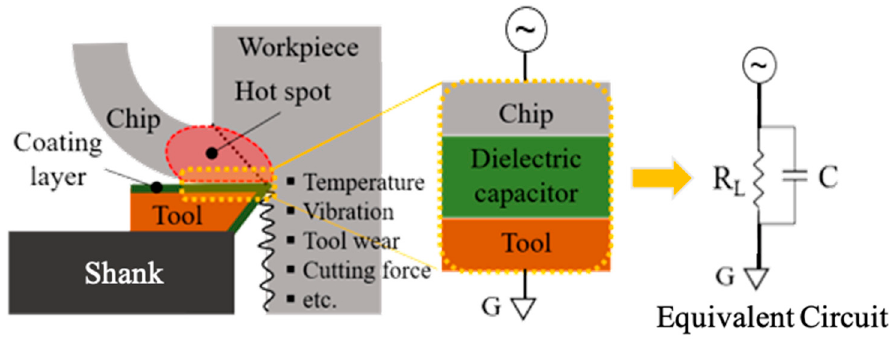
Figure 1. Schematic of metal cutting process and corresponding equivalent